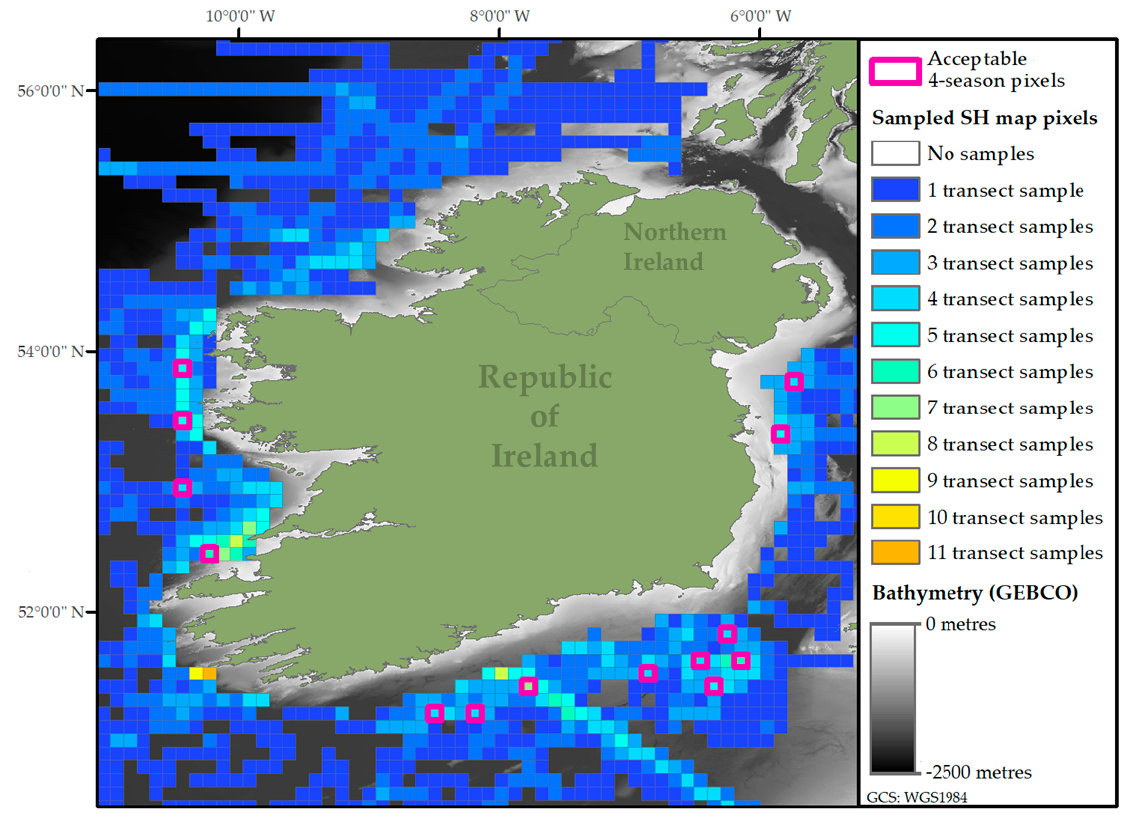
Figure 5. Map of in-situ Underway sampling intensity per-pixel in Irish waters, situated in the CSR case study area of this paper. The acceptable pixels to compare the STH and in-situ-derived heterogeneity values are denoted by open pink squares. These contained transit data from all 4 quarters of 2011, were nonadjacent, and were free of coastal effects .